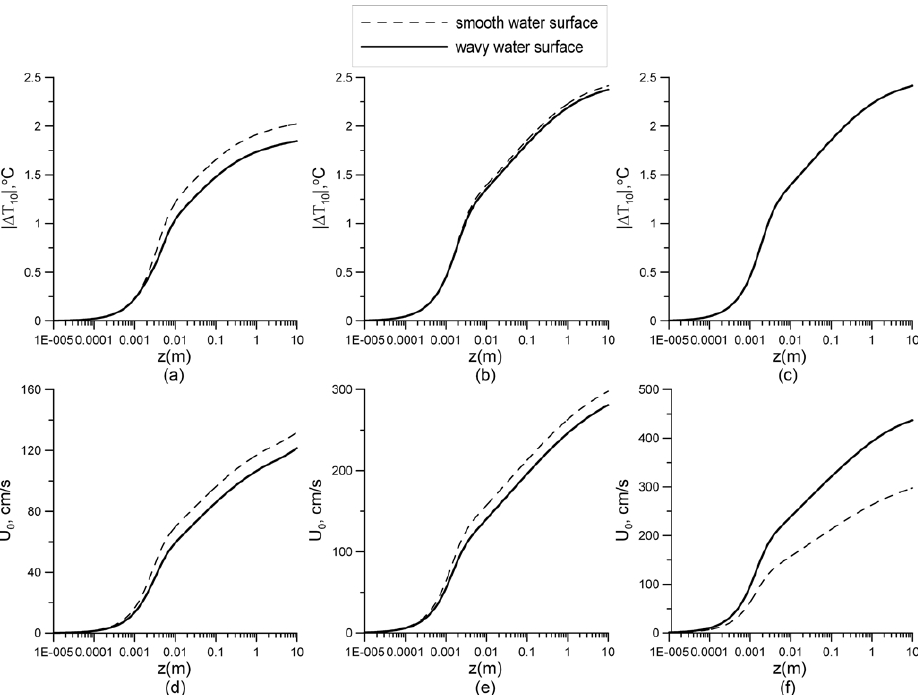
Fig. 4. Examples of the temperature (a,b,c) and velocity (d,e,f) profiles over wavy and smooth water surface, ka=0.1. (a,d) u ∗ = 5cms − 1 and k = 1cm − 1 , (b,e) u ∗ = 10cms − 1 and k = 0 . 33cm − 1 , and (c,f) u ∗ = 10cms − 1 and k = 0 . 001cm − 1 .